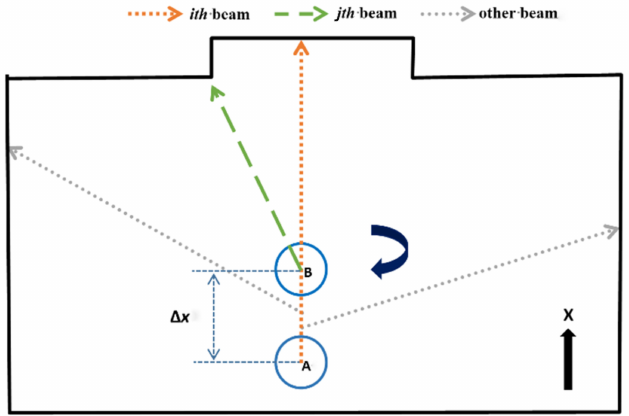
Figure 1. The acquisition process of one frame of LiDAR data.